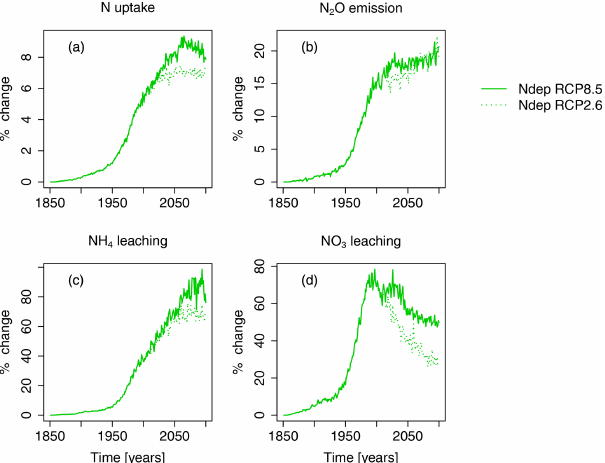
Figure 6. Nitrogen-deposition-induced change in percent of total N uptake by region, N 2 O emission, NH 4 leaching, and NO 3 leach- ing compared to preindustrial values in the simulation region. The nitrogen-deposition-induced change in percent is calculated from the simulation runs S3 and S5 (see Table 2). Solid lines indicate re- sults from simulations based on RCP8.5, and dotted lines are results from simulations based on